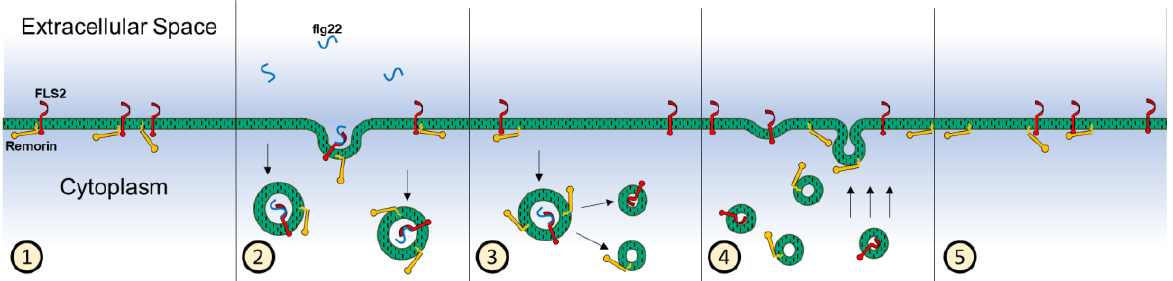
Figure 8. Illustration of the proposed model for protein internalization upon flg22 stimulation. (1) Native state of membrane proteins within the cellular membrane before stimulation, where FLS2 and remorin are typically colocalized in nanodomains. (2) Stimulation with flg22, where FLS2 binding with flg22 results in the internalization of nanodomains including remorin. (3) Smaller vesicles bud from the original endocytic vesicles, separating FLS2 and remorin into different vesicles. (4) Recovery of the proteins in the membrane, where remorin and FLS2 return to the membrane separately. (5) 90 min post-stimulation, where the density of the proteins in the membrane has recovered, and most remorin and FLS2 have colocalized or coordinated back into the same nanodomains.